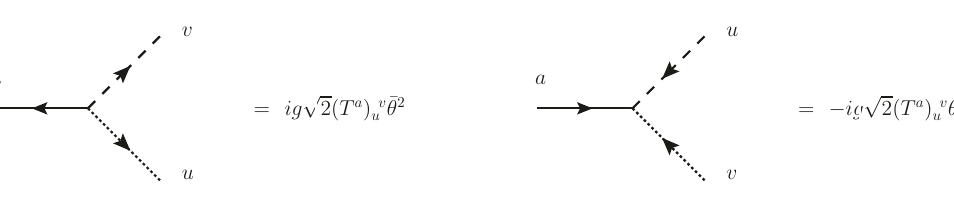
Figure 4 . Feynman rules involving (cid:8), Q and ~ Q chiral (cid:12)elds, with solid, dashed and dotted lines respectively.